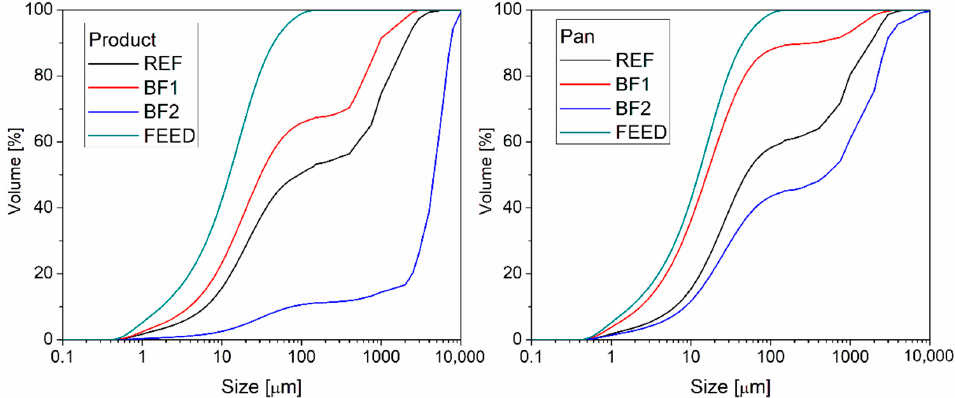
Figure 6. Influence of the feed flow on PSD of product and pan samples of the granulation.